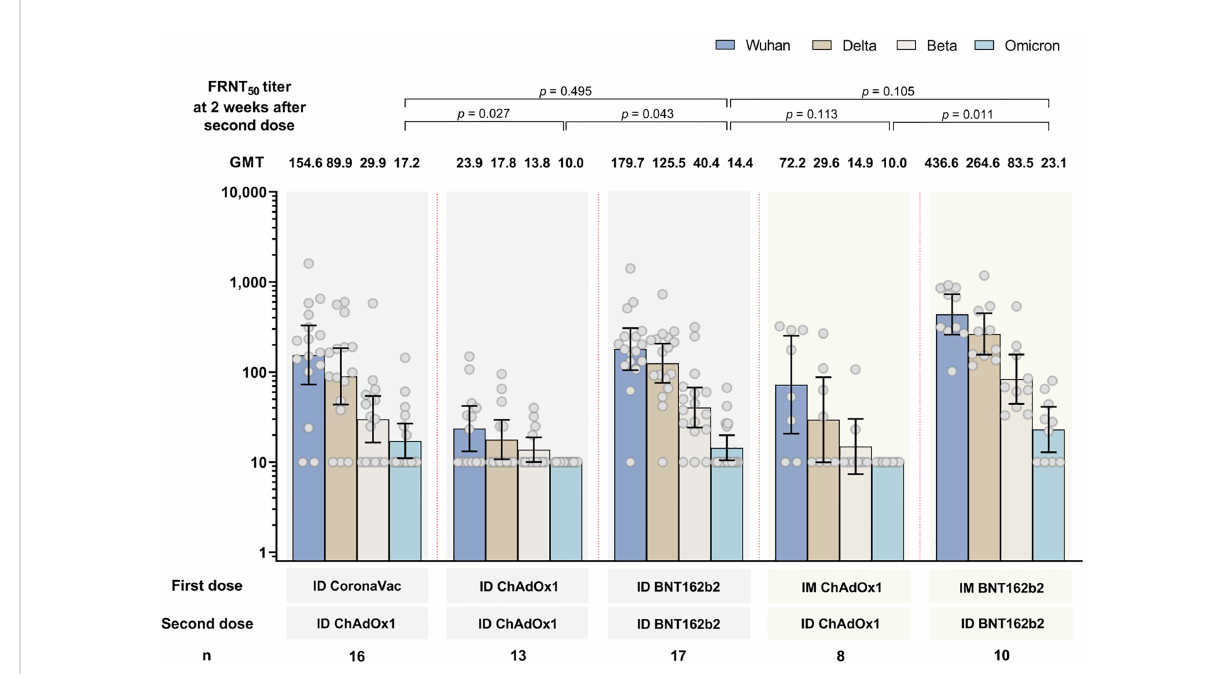
FIGURE 3 Neutralizing antibody titers (FRNT 50 ) by focal reduction neutralization test against SARS-CoV-2 ancestral strain and beta, delta and omicron variant strains at 2 weeks after the second dose. Data presented as geometric mean concentrations and 95% con fi dence intervals. GMT, geometric mean titers. n= number of participants. ID, intradermal; IM,